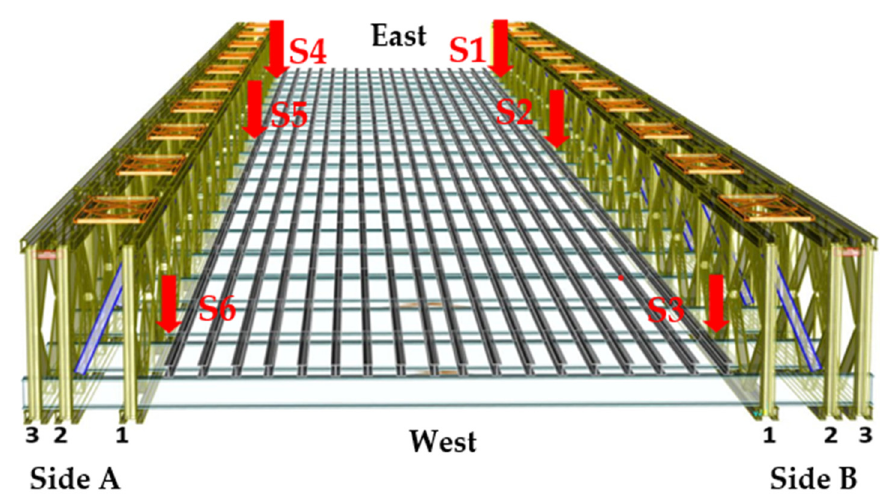
Figure 7. Positions of sensors.